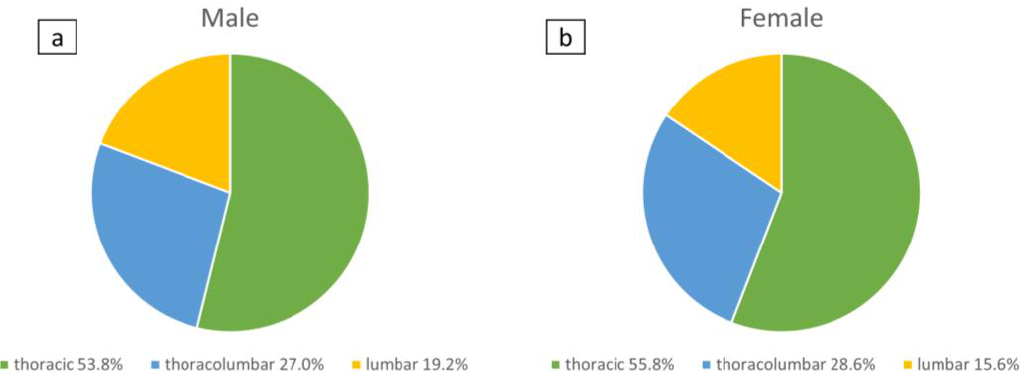
Figure 2. Diagram with inclusion and exclusion process.